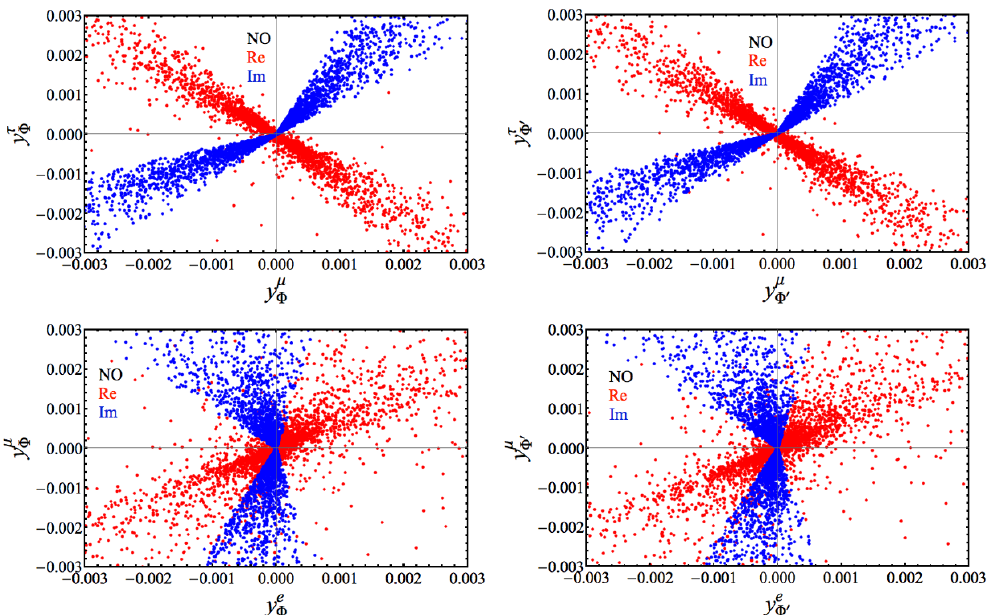
with normal ordering, separated according to real (in red) and imaginary parts (in blue). The upper panel shows the (cid:13)avour (cid:28) versus (cid:22) , while the lower one shows (cid:22) versus e .